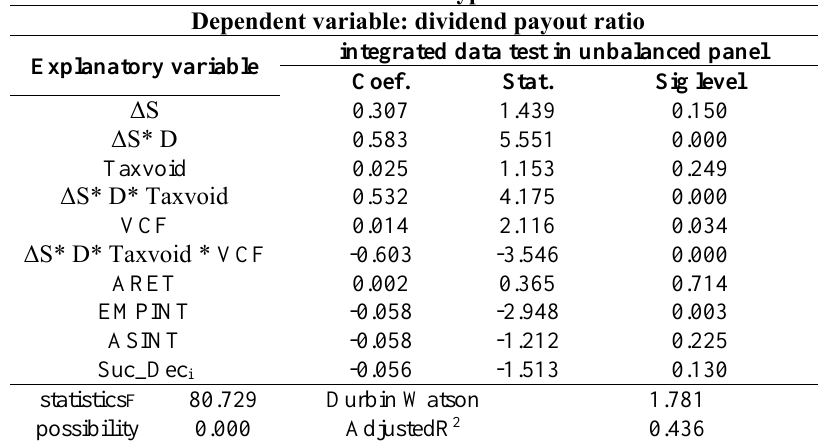
Table 5. Results of hypotheses test Dependent variable: dividend payout